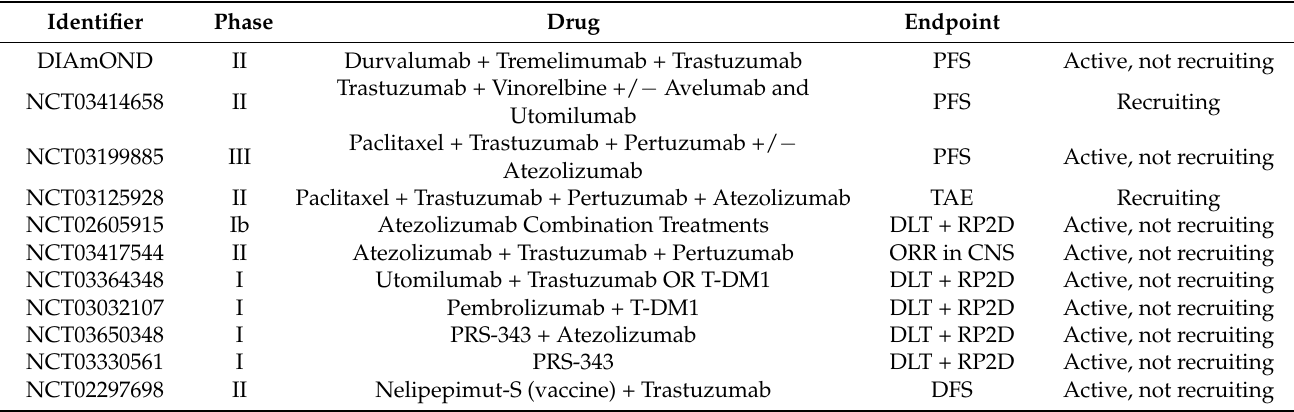
Table 4. Currently ongoing trials with